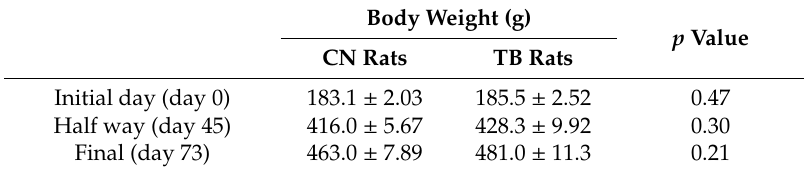
Table 2. Body weights for control rats (CN rats) and theobromine-fed rats (TB rats) in experiment 2.